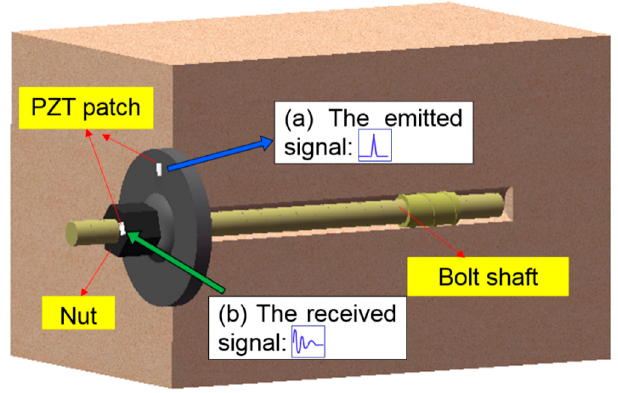
Figure 10. A PZT patch as a sensor on the nut for an existing rock bolt.